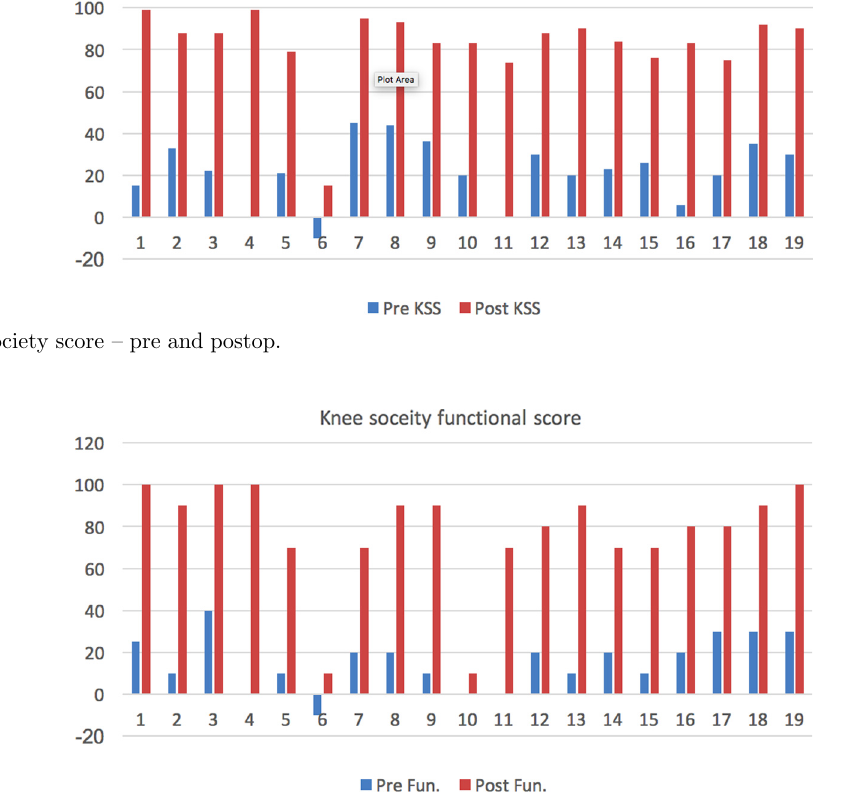
Figure 5. Knee Society functional score (cid:1) pre and